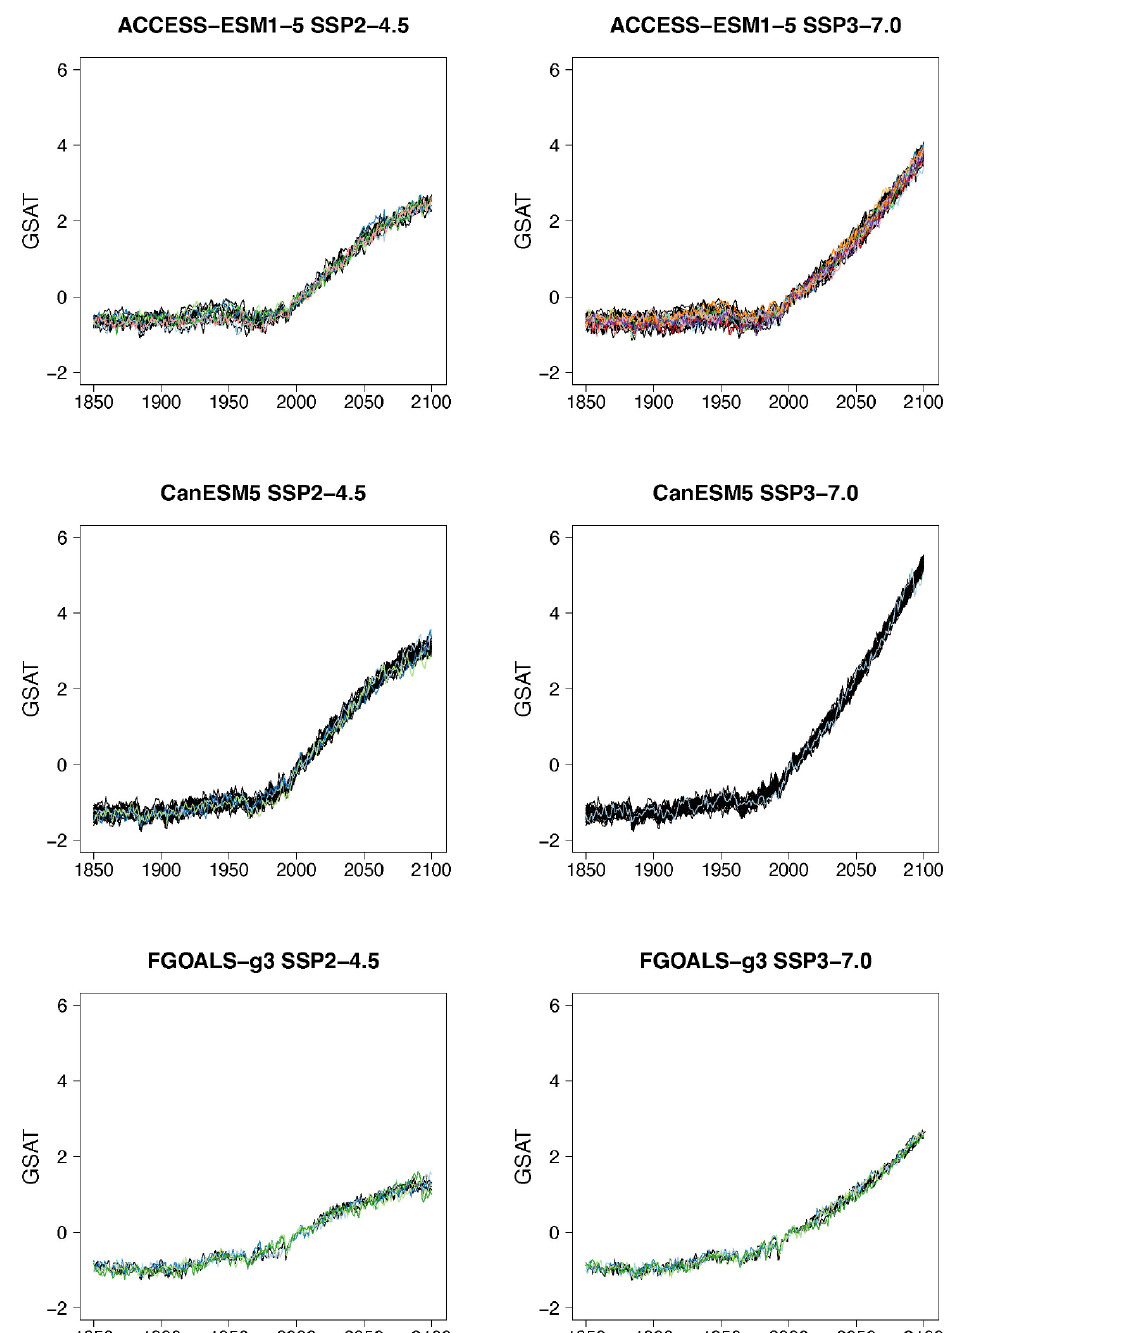
Figure B3. Examples of target (black lines) and stitched (colored) GSAT time series for ESMs in the PANGEO archive that ran at least one trajectory along the Tier 1 experiments of ScenarioMIP (SSP1-2.6, SSP2-4.5, SSP3-7.0, SSP5-8.5). We use the two bracketing scenarios and emulate trajectories that follow the two intermediate